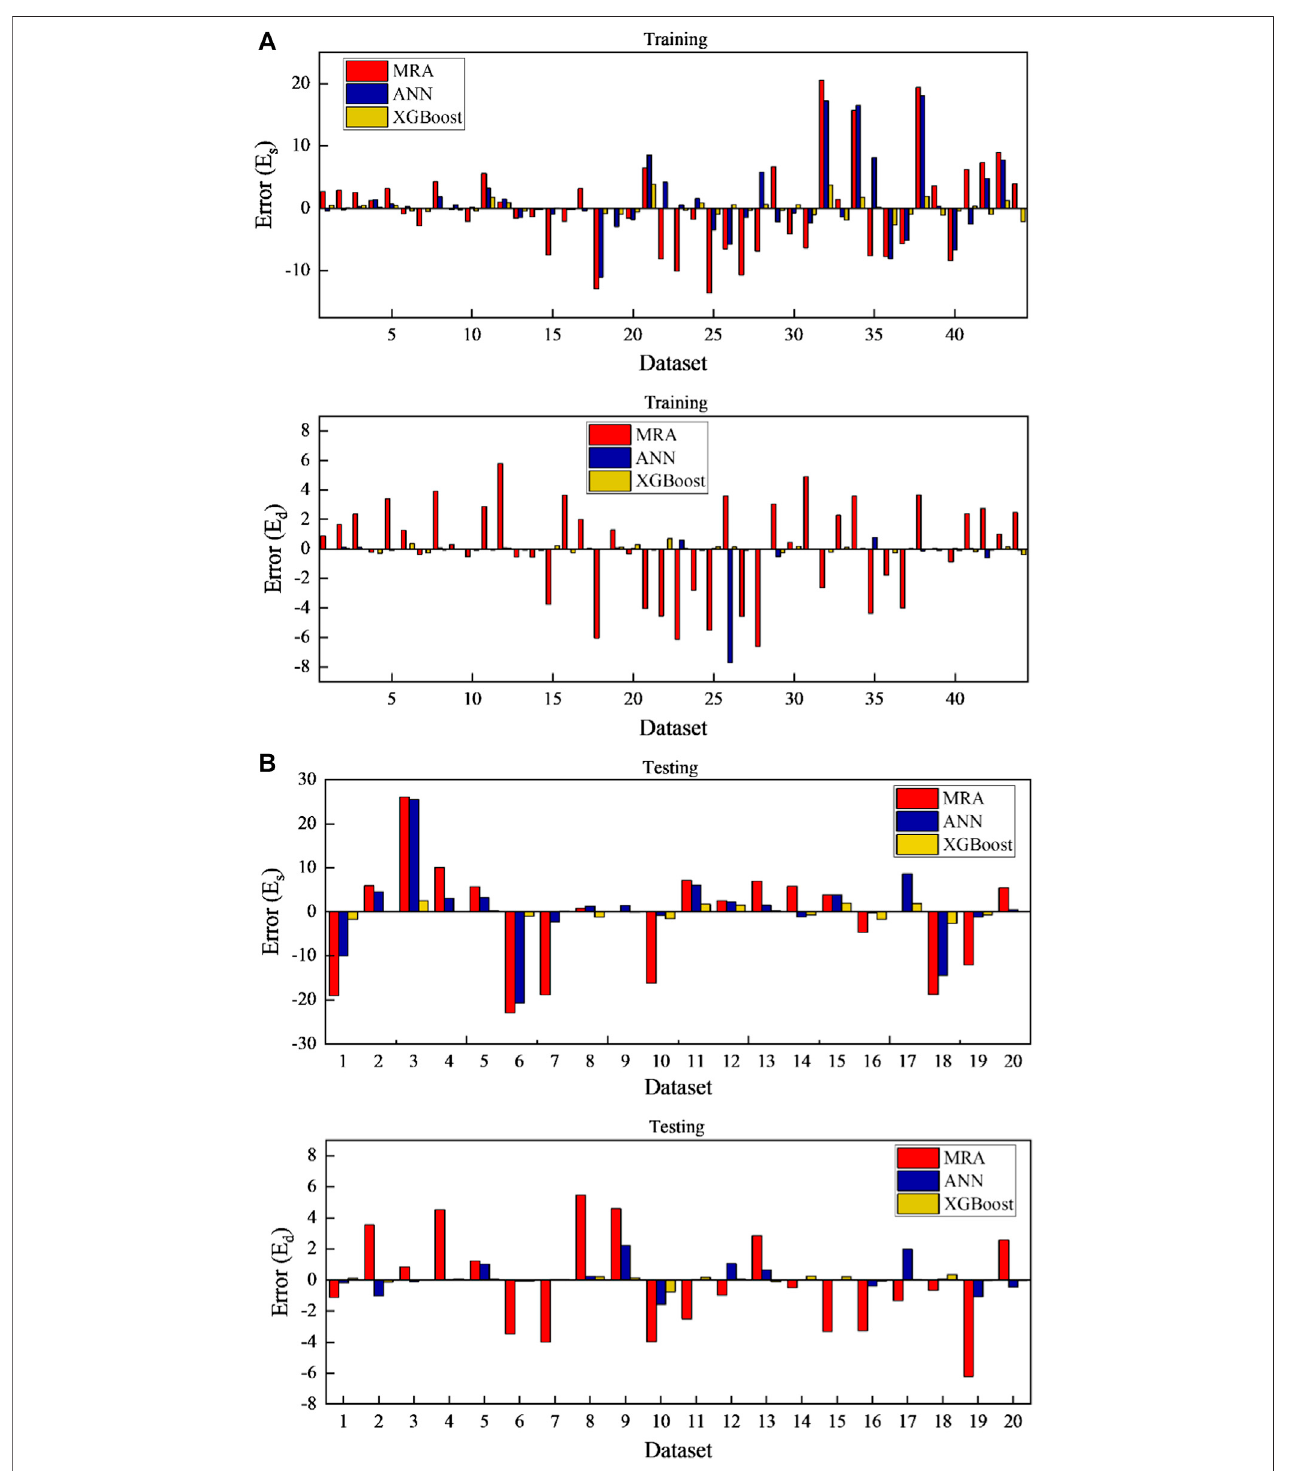
FIGURE 10 | Change of relative error between predicted and original data of proposed models in the (A) training stage and (B) testing stage for E s and E d .